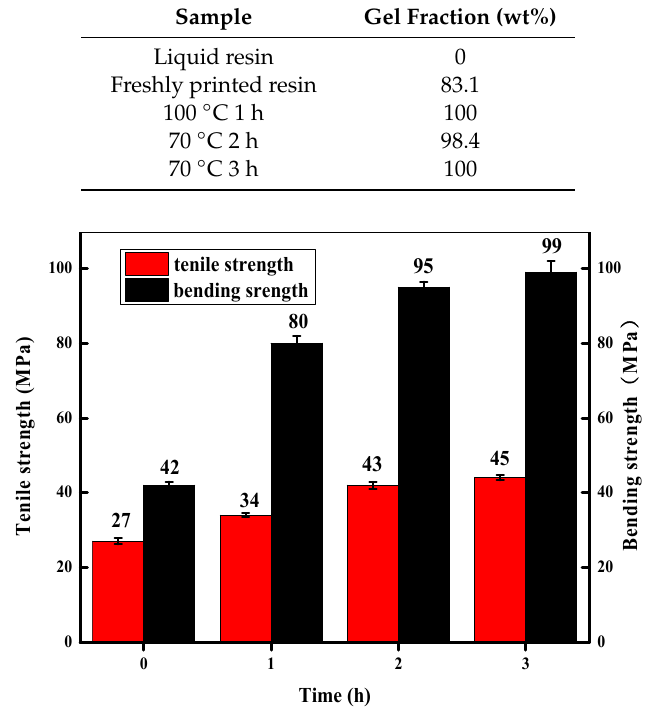
Table 3. Gel fractions of the samples with various heat treatment conditions.